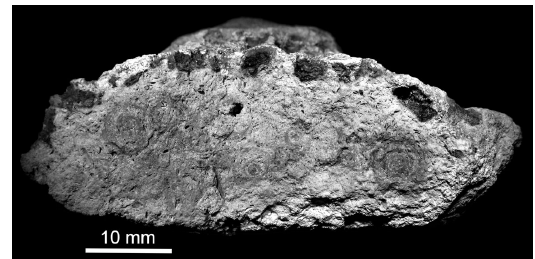
Fig. 9. Fragment of a type 1 boulder showing transverse sections of burrows. RGM 1317646, Wilsum.